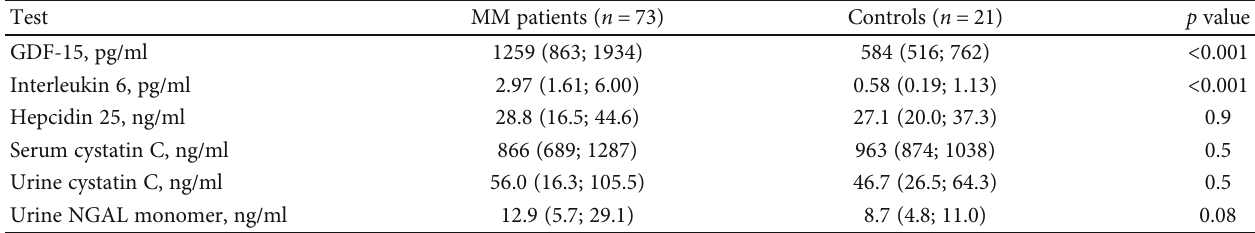
Table 4: Laboratory results in MM patients as compared to control